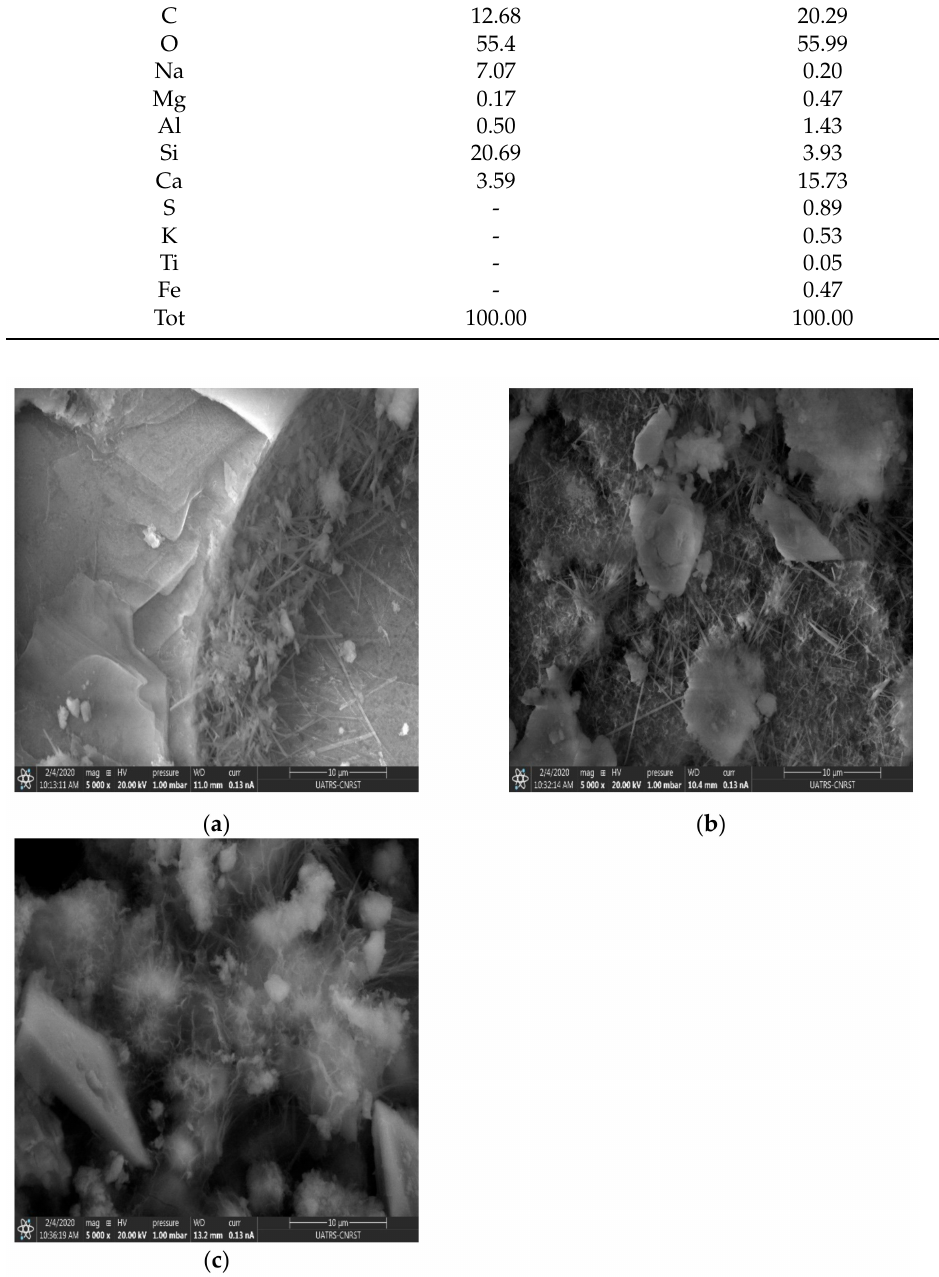
Figure 6. Scanning electron microscopy of: ( a ) Control mortar; ( b ) Mortar glass powder (10%); ( c ) Mortar glass powder